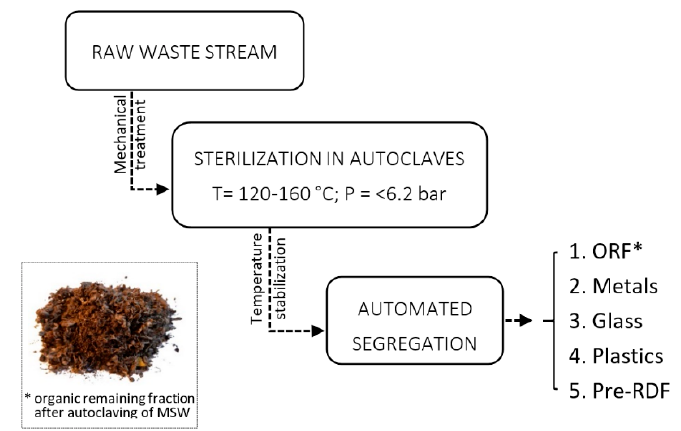
Figure 1. Flow-chart illustrating a process for Mechanical Heat Treatment of Municipal Solid Waste.